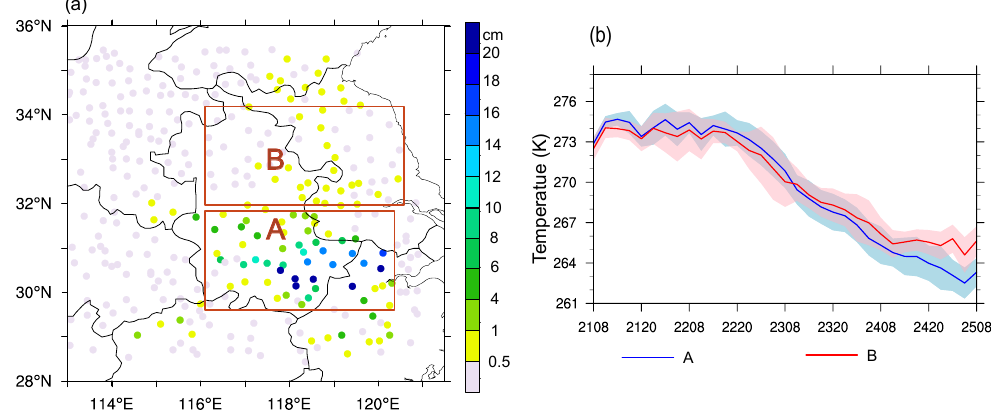
Figure 9. ( a ) The snow depth at 2 am on 24 January 2016 over the area surrounded by the brown rectangle in Figure 8g and ( b ) the time-series of the 2 m temperature during 21–25 January 2016 (the solid blue and red lines are the areal mean temperatures of areas A and B, and the shaded areas are their 1 standard deviation. The time coordinate is the same as that in Figure